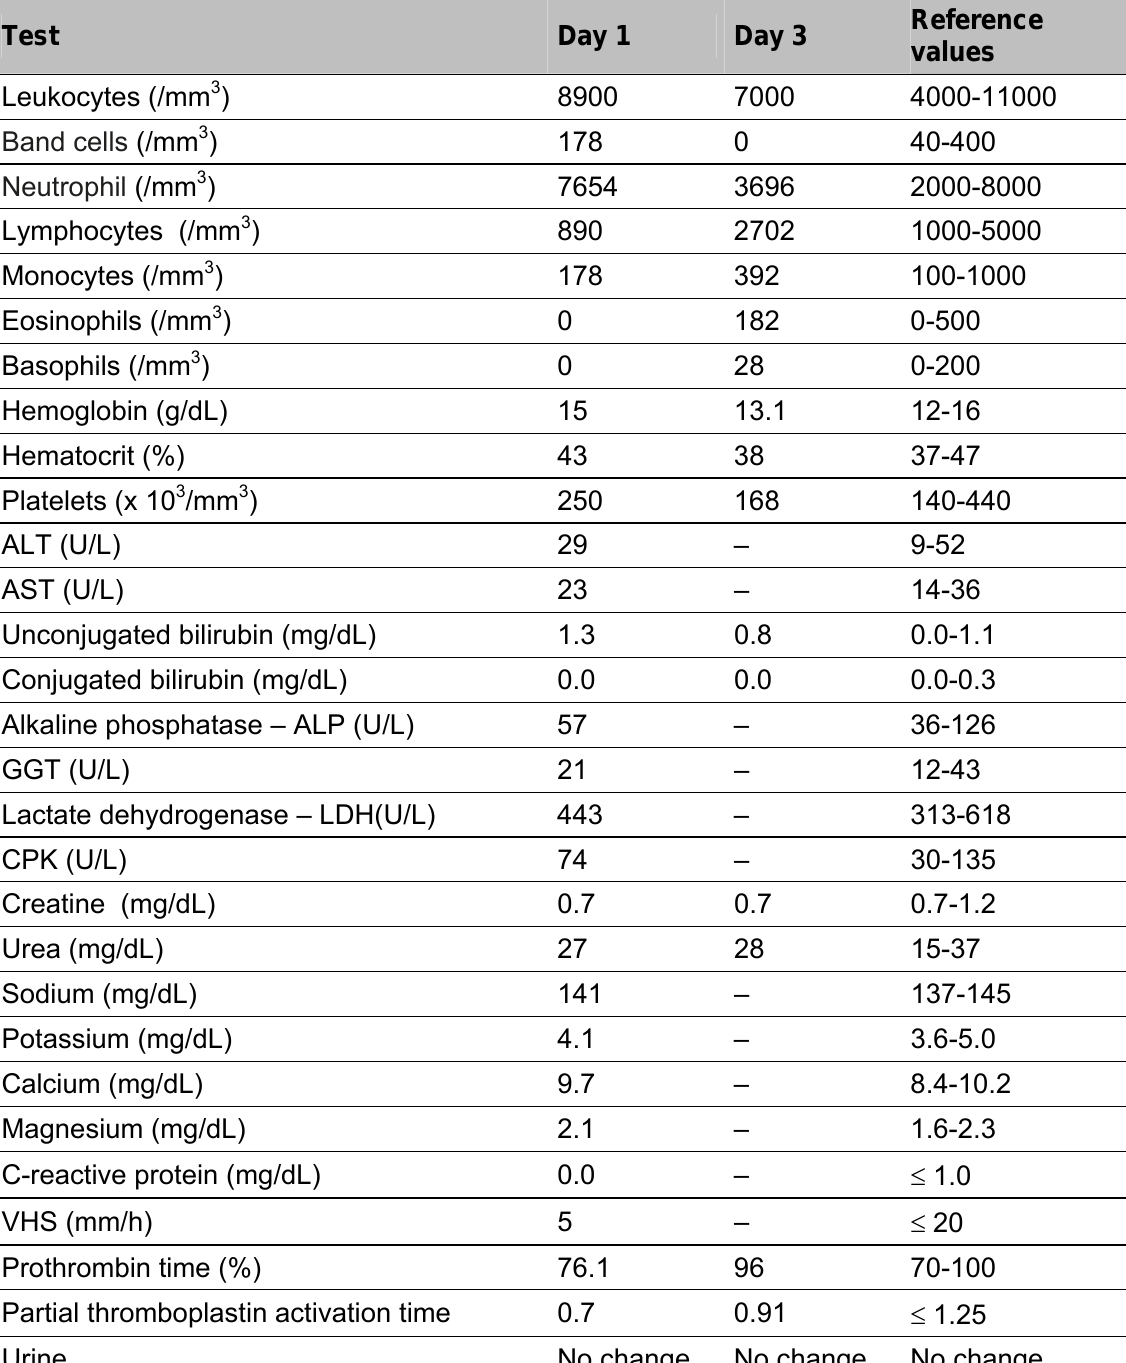
Table 1. Laboratory tests at patient admission (day 1) and after discharge from